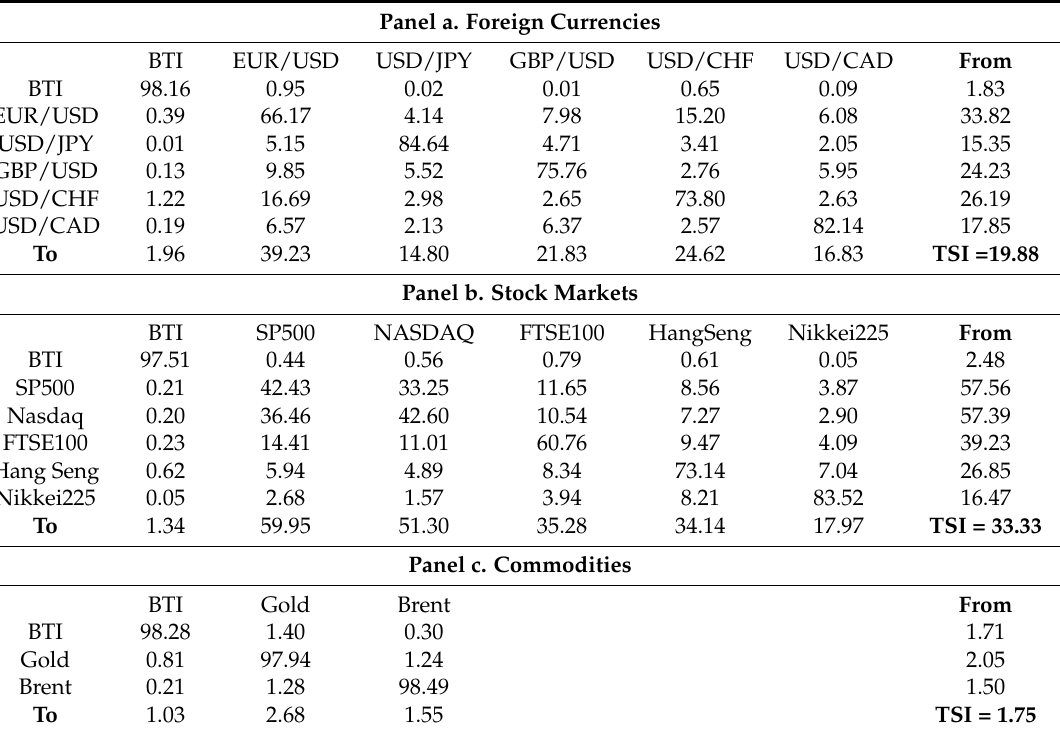
Table 4. Spillover effects within the cryptocurrency